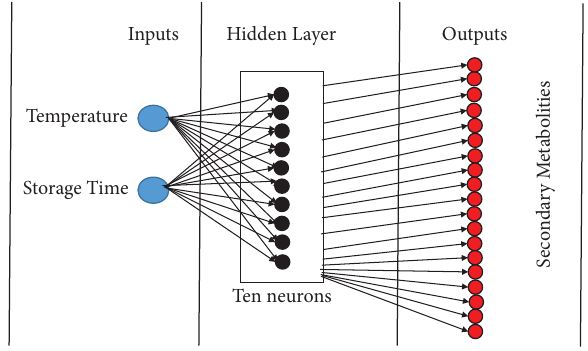
Figure 2: Te structure of the artifcial neural